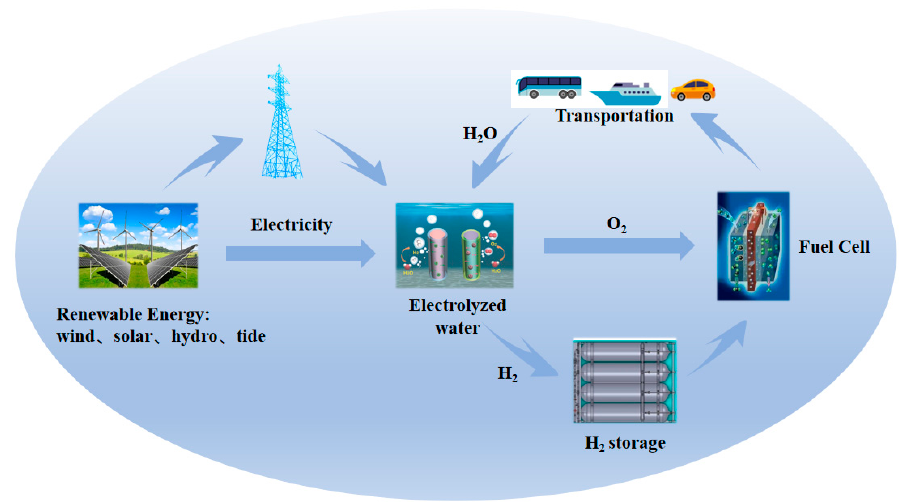
Figure 1. Schematic of sustainable pathways for energy conversion and storage based on electroca- talysis.